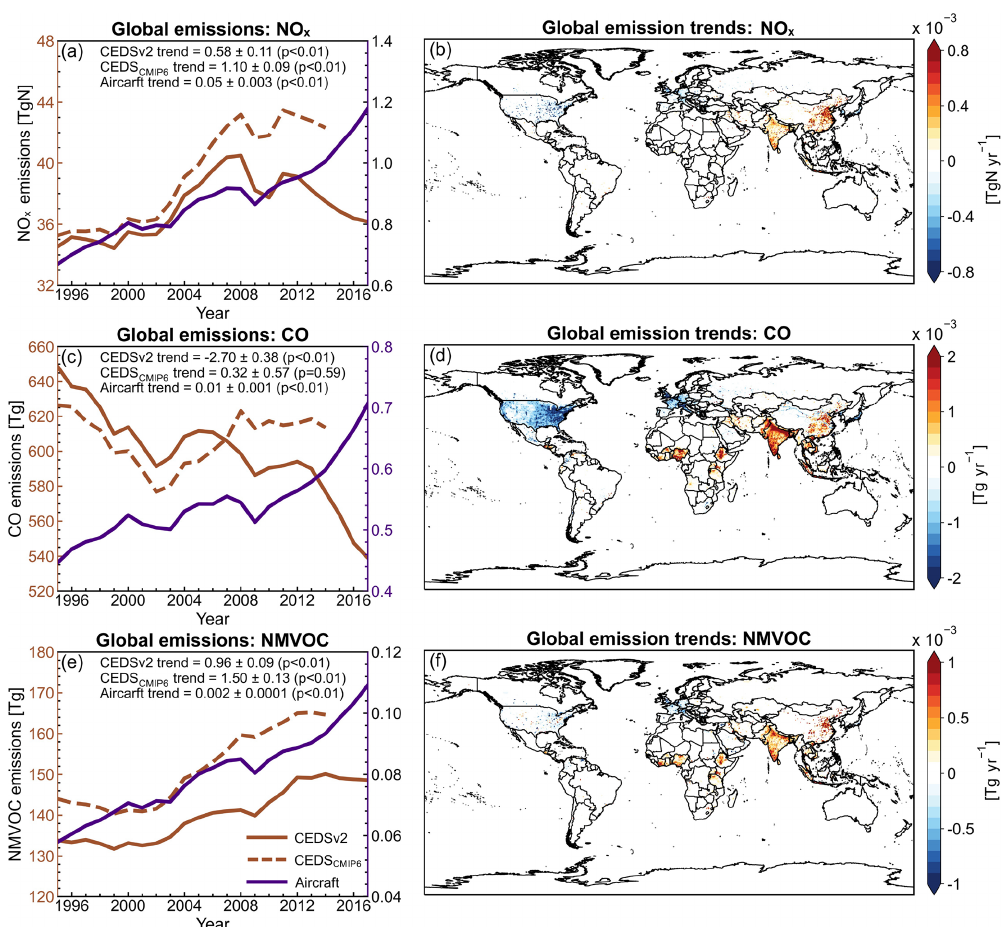
Figure 2. Trends in global annual anthropogenic (excluding aircraft emissions) and aircraft emissions of NO x , CO, and NMVOCs from 1995 to 2017. (a, c, e) The total global anthropogenic NO x , CO, and NMVOC emissions from the CEDSv2 and CEDS CMIP6 inventories. (b, d, f) The spatial distribution of emission trends in the CEDSv2 inventory. Aircraft emissions are from O’Rourke et al. (2021). The total global anthropogenic emission trends with p values are shown in the left